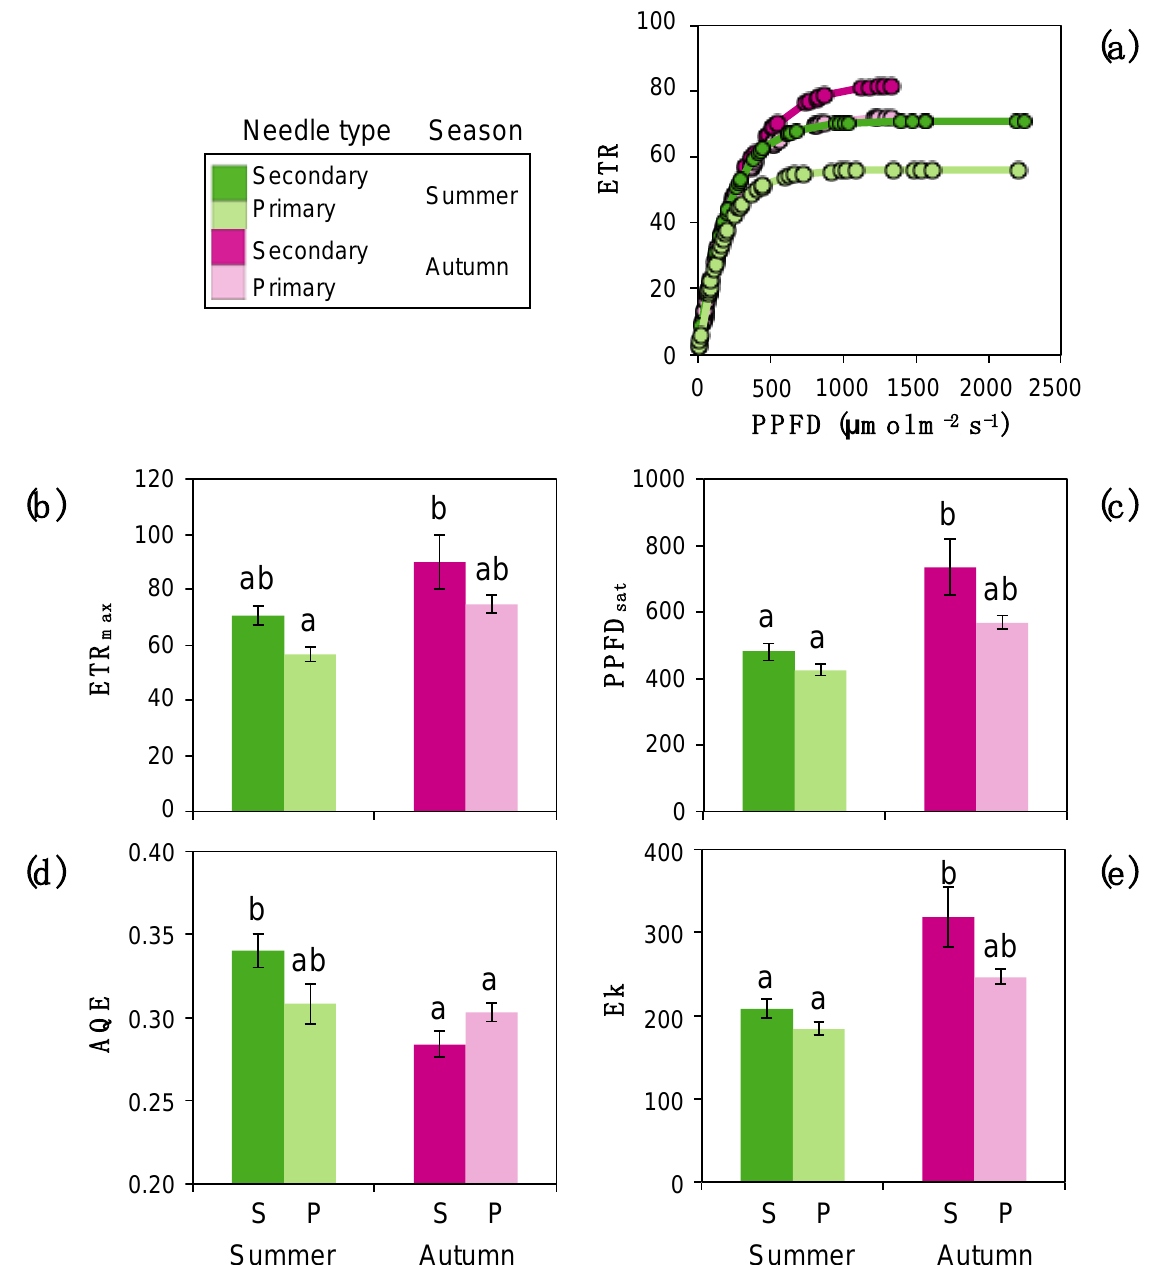
Figure 5. Rapid Light Curves and derived parameters as estimated through chlorophyll fluorescence analyses, of P. canariensis needles. ( a ) Light curves showing electron transport rate (ETR, in µ mol electrons m − 2 s − 1 ) achieved by the needles at each photosynthetic photon flux density (PPFD, in µ mol photons m − 2 s − 1 ). ( b ) Maximum electron transport rate (ETR max ) expressed in µ mol electrons m − 2 s − 1 . ( c ) Maximum PPFD at which the maximum ETR is maintained (PPFD sat ) expressed in µ mol photons m − 2 s − 1 . ( d ) Apparent quantum efficiency (AQE) expressed in µ mol photons used for photochemical processes per µ mol photons absorbed by PSII. ( e ) Minimum saturating irradiance (Ek) µ mol photons m − 2 s − 1 . Data are mean ± SE ( n = 4). Different letters above bars depict significant differences among needle types and seasons ( p < 0.05). See Section 2.3 of the Materials and Methods for details on how the parameters shown in panels ( b – d ) were estimated.